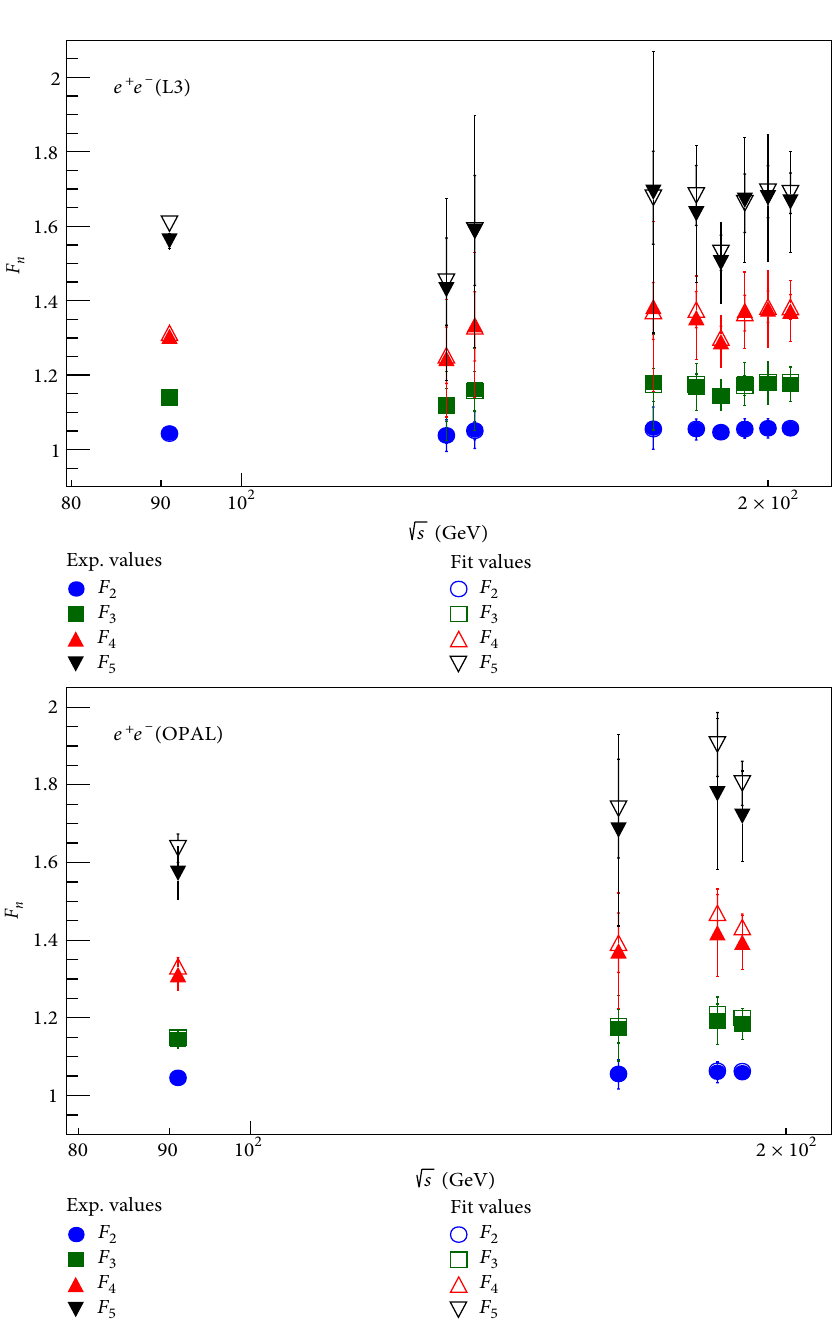
Figure 6: Normalized factorial moments of modified shifted Gompertz distribution for the experiments at different